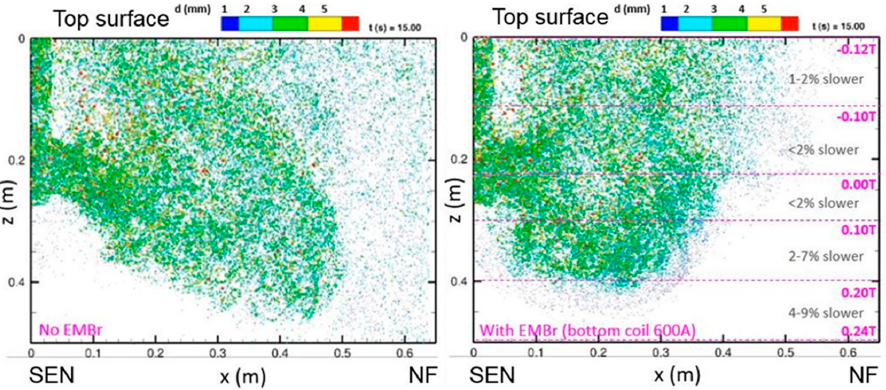
Figure 21. Bubble distributions in a slab caster centerplane ( a ) without and ( b ) with double-ruler EMBr [138].